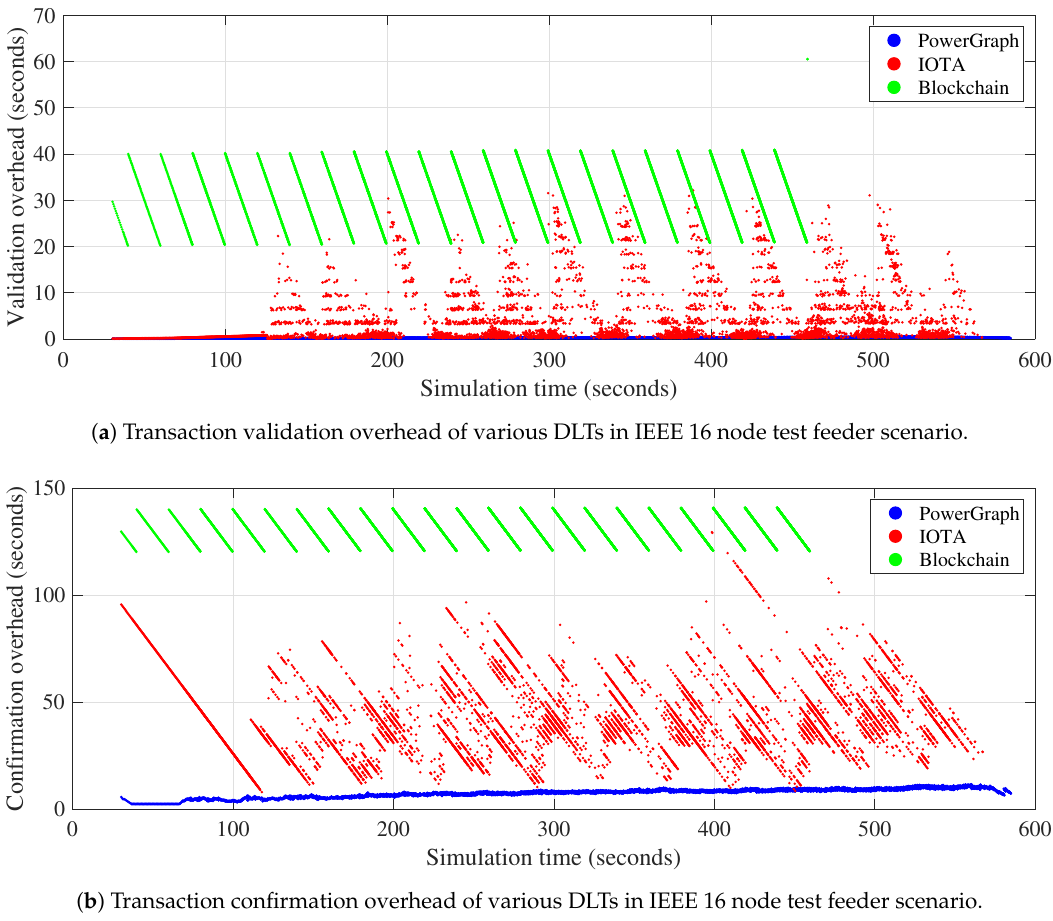
Figure 12. Simulation results in IEEE 16-node test feeder